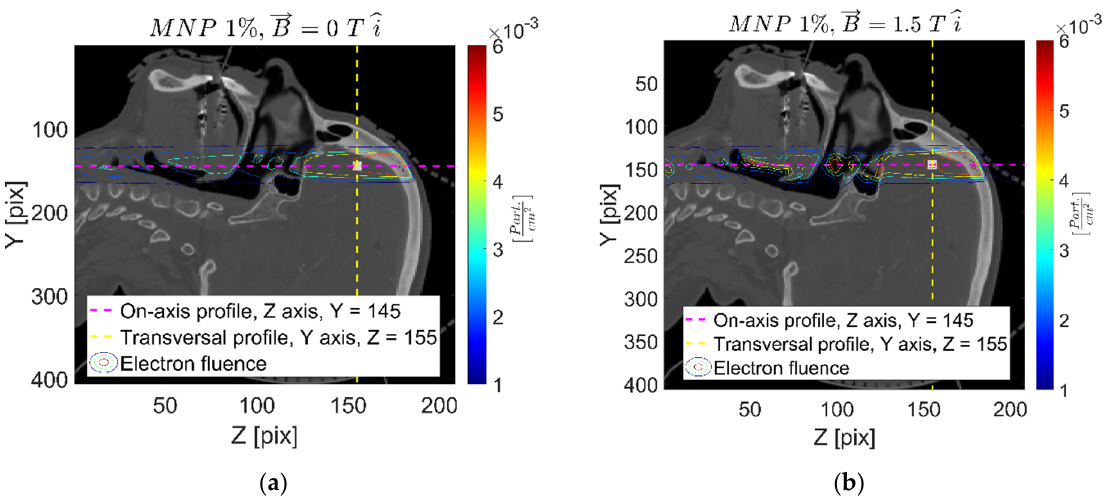
Figure 2. Secondary charged particle fluence map, sagittal plane, for the 1 ‐ 0 ( a ) and 1 ‐ 1.5x ( b ) cases.